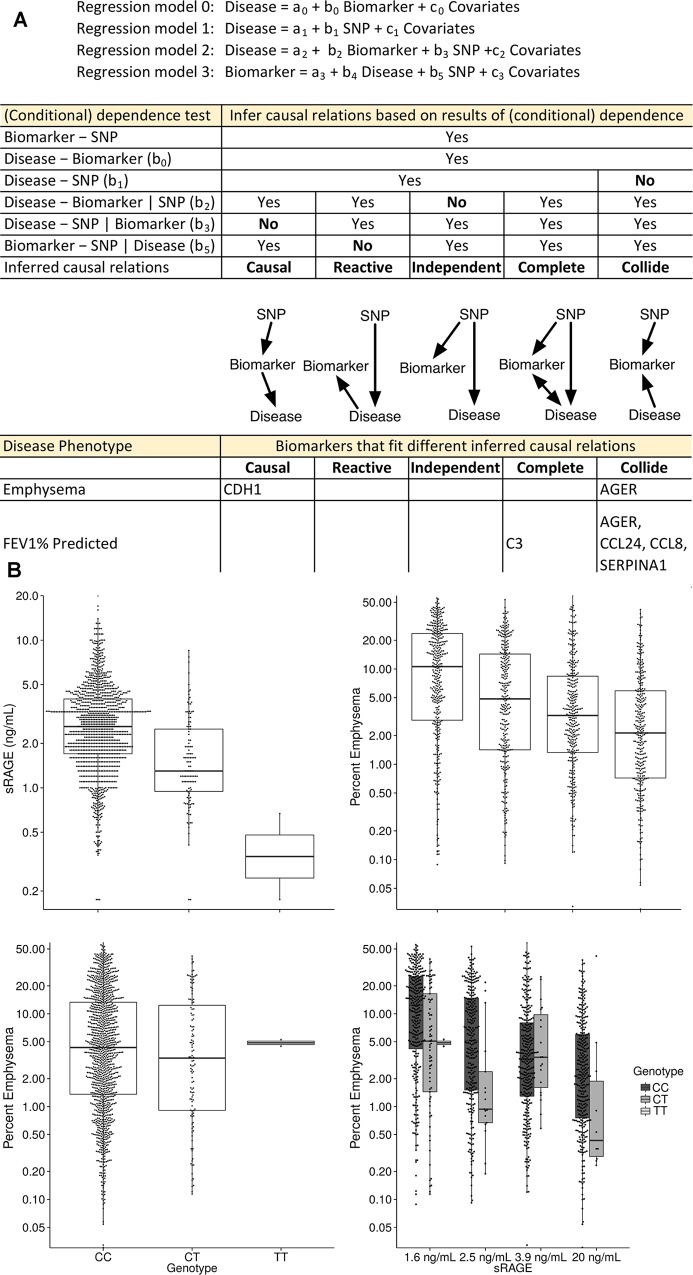
Clinical and biologic significance of pQTL SNPs.(A) Biomarker pQTL SNPs were tested for association with four different COPD disease phenotypes: emphysema, airflow limitation (FEV1%), chronic bronchitis, and exacerbations using four different statistical regression models to infer the causal relations of causal, reactive, independent, complete or collide. A complete listing of pQTL SNPs disease association p-values for both cohorts can be found in S8 Table. Note that testing b2 = 0 and b4 = 0 are equivalent because in both cases, we are testing whether the disease and biomarker is conditionally dependent given SNP. Therefore, we only examined b2 in our analysis. No significant results were obtained for chronic bronchitis or exacerbations and so these two phenotypes are not shown. (B) The T allele of rs2070600 is associated with lower plasma levels of sRAGE and (C) lower plasma levels of sRAGE (shown by sRAGE quartile) are associated with more emphysema on quantitative CT scan (model 0); (D) the T allele is not clearly associated with emphysema when considering only the SNP-disease association (model 1); however, (E) the T allele is associated with less emphysema within each biomarker quartile (model 2), and the SNP fits the collide model.